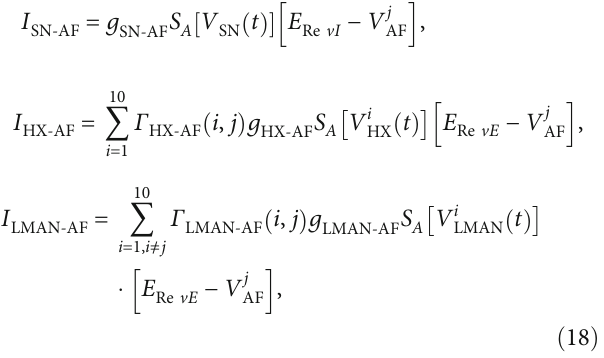
, are activated by IN